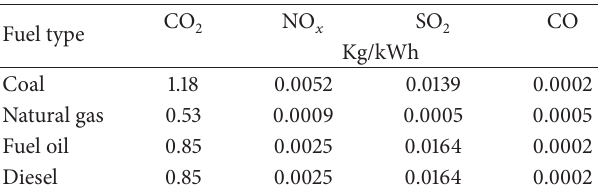
Table 1: Emission factors (kg/kWh) used for estimating emission in power plants.